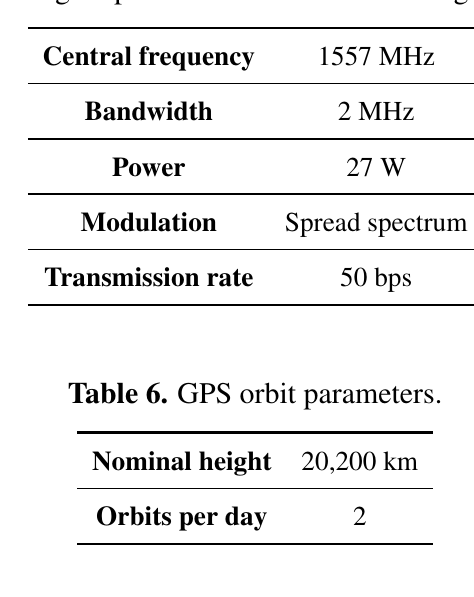
Table 5. GPS signal parameters used in the third geometry study.